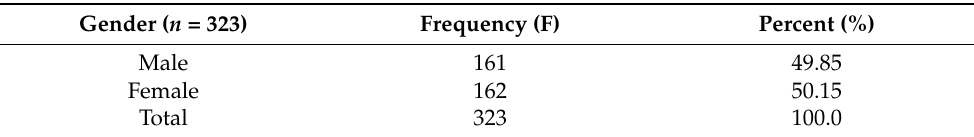
Table 1. Frequency and percentage of respondent gender.